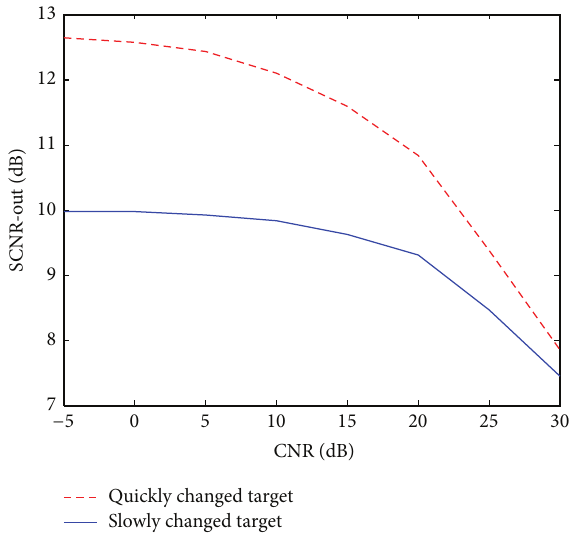
Figure 8: The output SCNR versus input CNR in slowly and quickly changed target